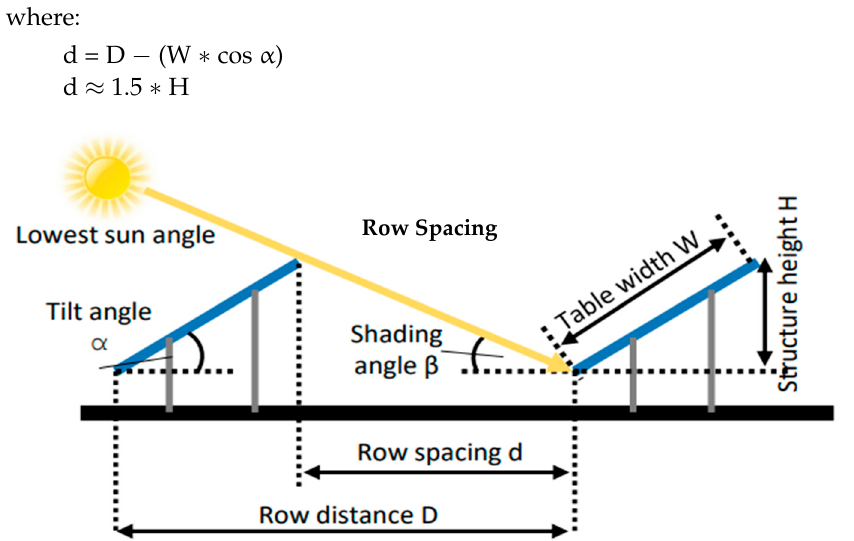
Figure 7. Minimum row spacing dimensions.